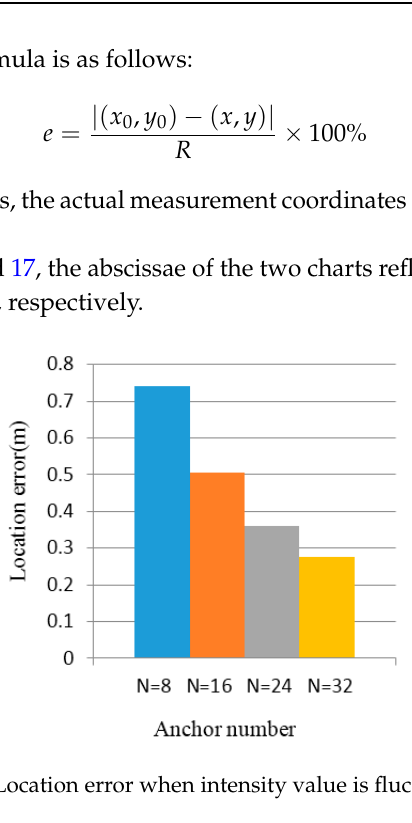
Figure 17. Location error when intensity value is fluctuation 10%. Figure 18 shows the localization algorithm, SBL [18], three-centroids in a triangle with a sequence algorithm [19], and three-centroids in a triangle [14]; the error trends are correlated with the number of anchor nodes. The position error curve basically showed a decline. More than 20 unknown nodes are randomly generated, and calculate the coordinates of these nodes, when the number of anchor nodes are 32=,24=,16=,8= NNNN , respectively; the average positioning error of the unknown nodes are 0.8 m, 0.5 m, 0.4 m, and 0.3 m. The positioning error of the algorithm is less than 1 m.